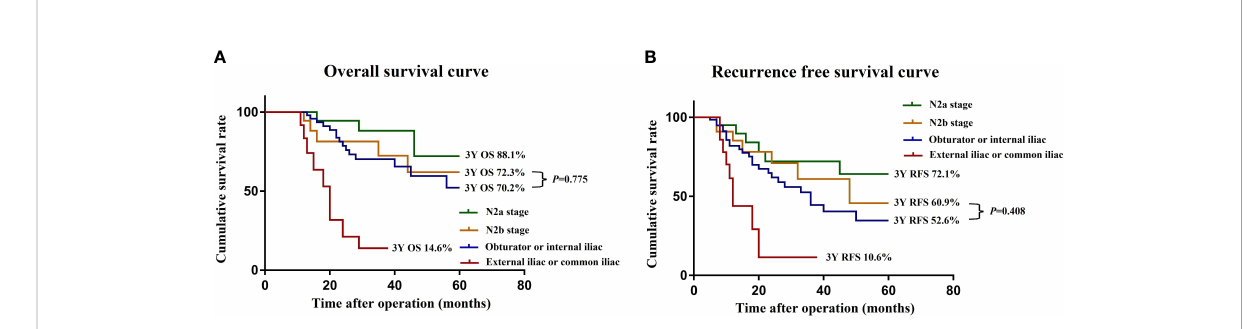
FIGURE 3 OS (A) and RFS (B) curves of patients with LPN metastasis and N2 stage after subgroup analysis. OS , overall survival; RFS , recurrence-free